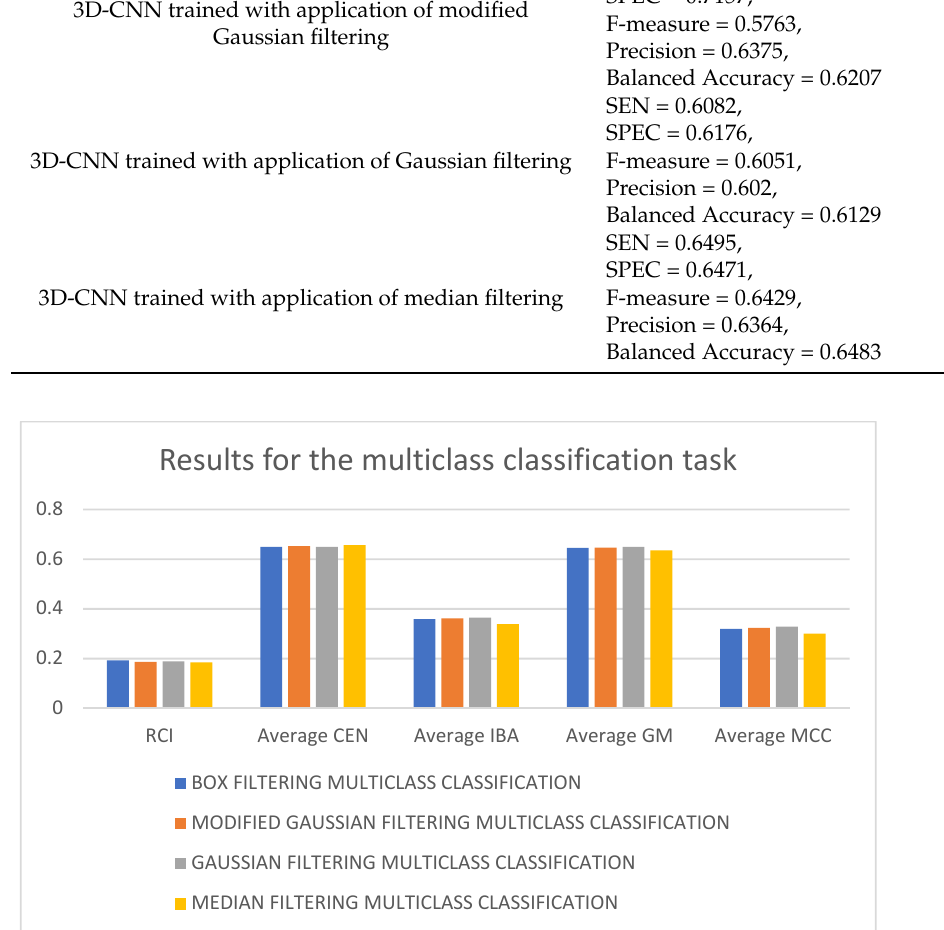
Figure 3. Results of different 3D-CNN architectures for the multiclass classification task.